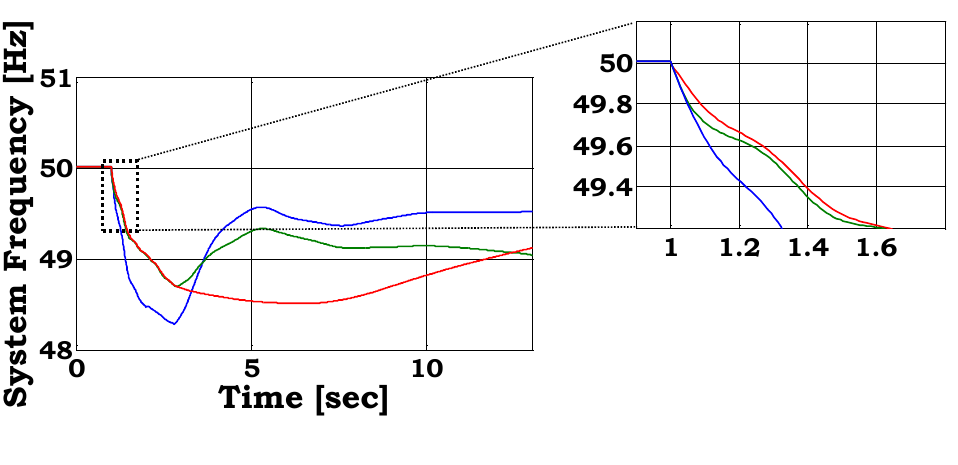
Figure 9 . Power system frequency and change in DFIG active power for largest unit loss—no auxiliary control (blue line), inertia control (red line), droop control (green